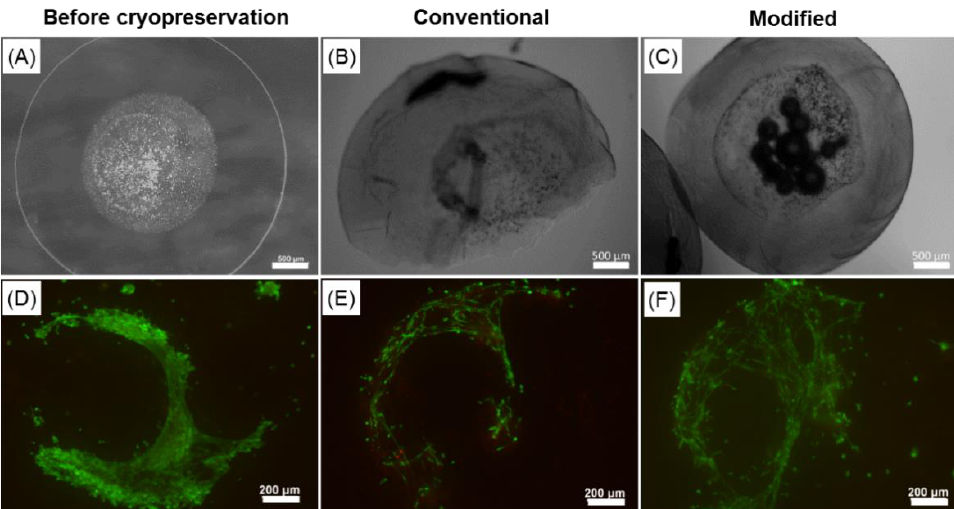
Figure 9. Bright field ( A – C ) and fluorescent images ( D – F ) of cj aMSCs encapsulated in core-shell capsules before freezing and after thawing using conventional and modified approaches. Conventional cryopreservation was associated with a noticeable damage to the capsules’ integrity ( B ) and decrease in cell viability ( E ). The cell viability was analysed 24 h after thawing using live-dead assay indicating live cells in green fluorescence and dead cells—in red. A much higher amount of viable cells within cellular networks is seen in samples protected with the modified protocol ( F ). Scale bars are 500 µm ( A – C ) and 200 µm ( D – F ).